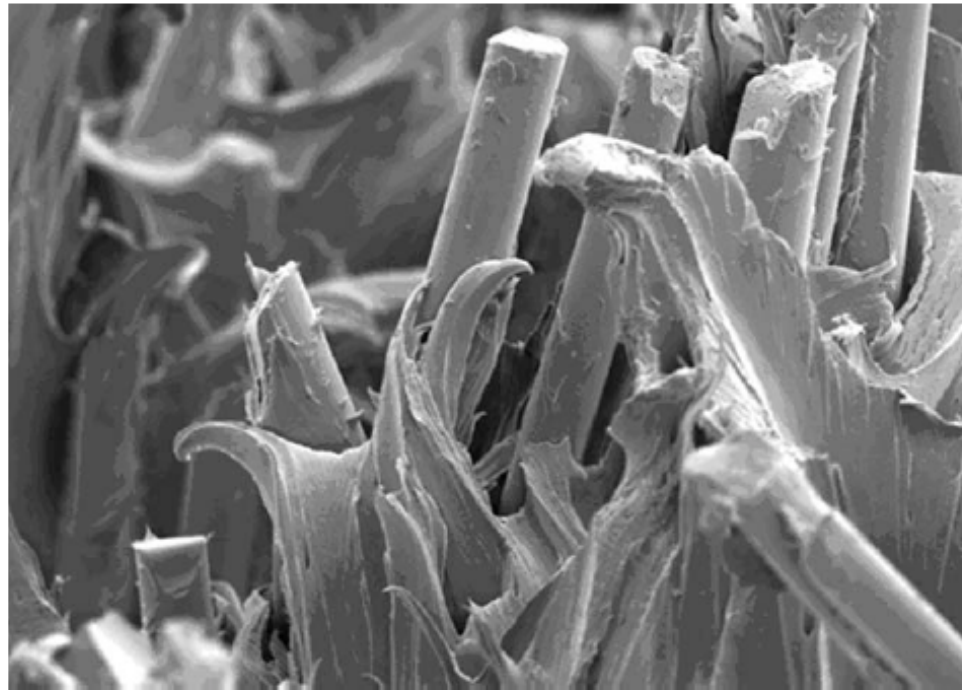
Figure 16. Internal structure of PA66GF35 (matrix interface fiber) X175 Mag.